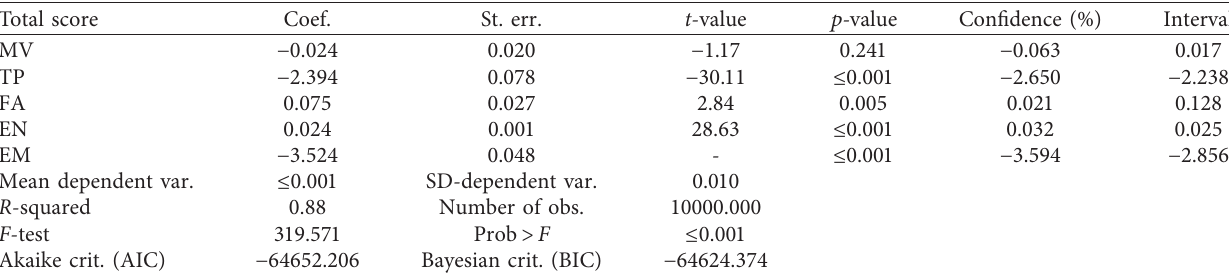
Figure 2: Residual and lever values. Table 1: The United States indicator of stepwise regression